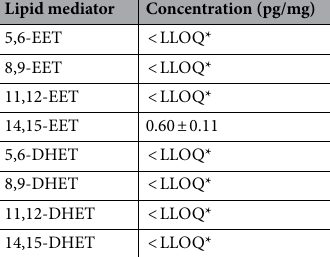
Table 1. Targeted quantification of Cyp epoxygenase- and sEH-derived arachidonic acid lipid metabolites in the ophthalmic artery. * LLOQ lower limit of quantification.